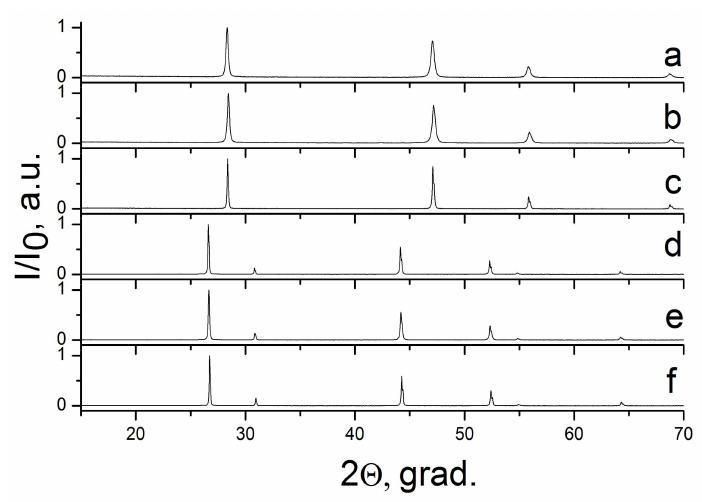
Figure 7. X-ray diffraction patterns of CaF 2 : Samples 8 ( a ), 9 ( b ), 11 ( c ), and SrF 2 : Samples 12 ( d ), 13 ( e ), 16 ( f ) specimens synthesized from NaNO 3 flux.